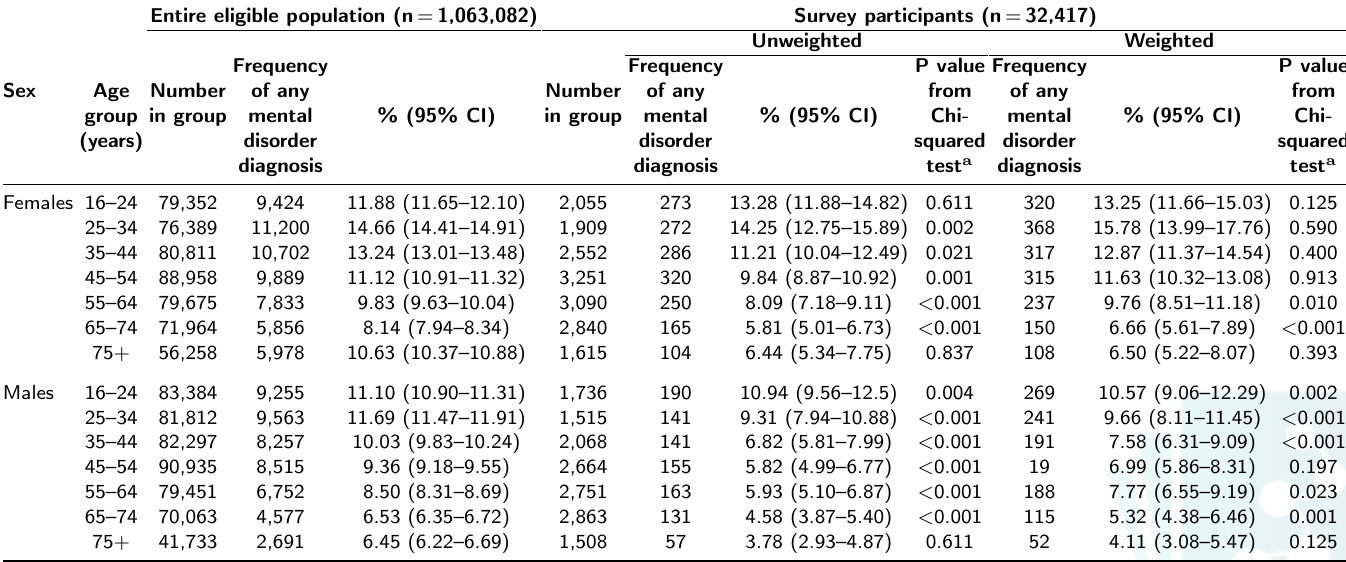
Supplementary Table 5: Frequency of any mental disorder diagnosis in specific sex- and age-groups within of the eligible population in the Central Denmark Region and the How are you? survey participants (unweighted and weighted) Entire eligible population (n =